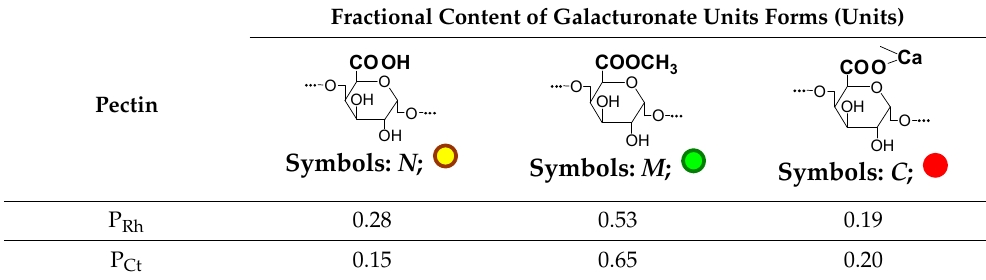
Table 4. Analysis results of the chemical structure of pectin preparations. Pectin